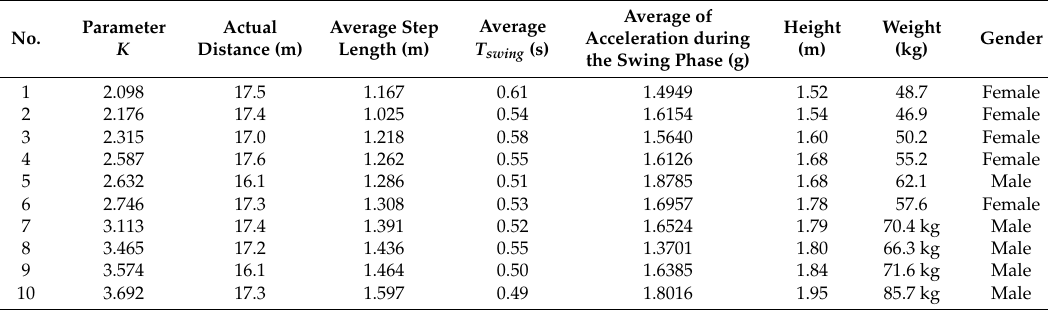
Table 2. Basic body characteristics and the calibration results of each